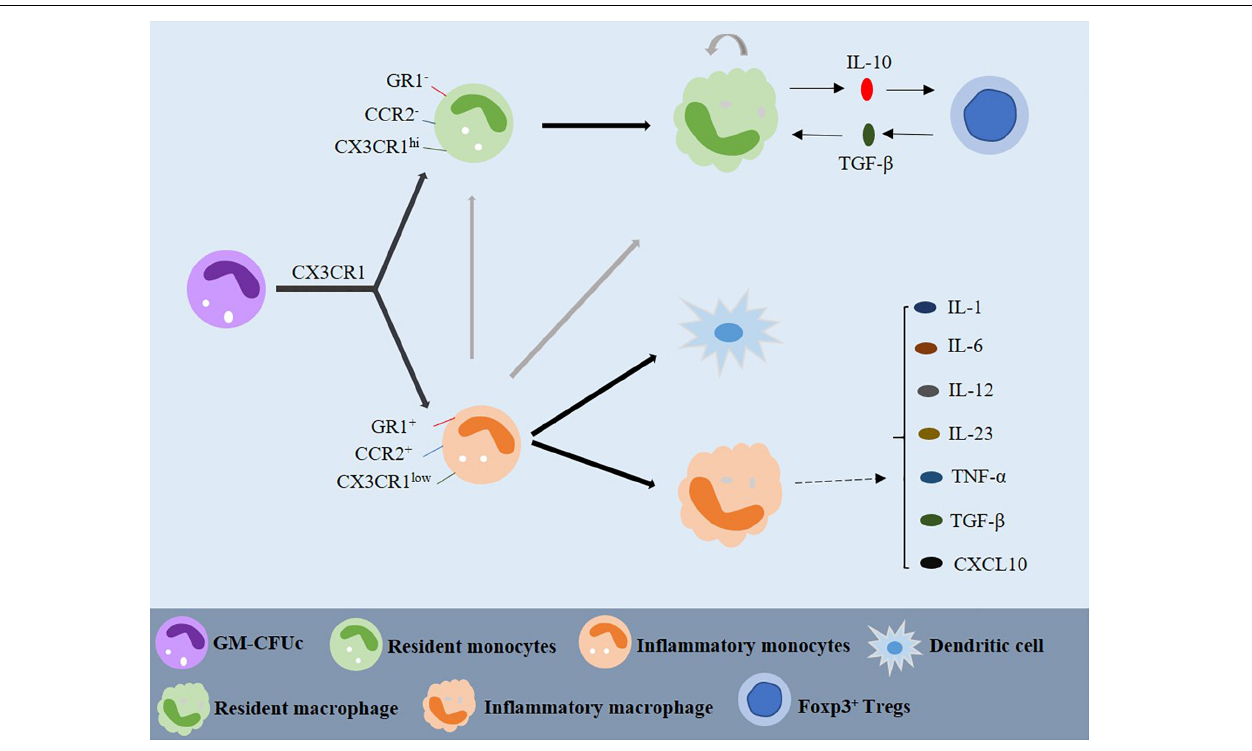
FIGURE 2 | Origin and differentiation of macrophages. GM-CFUc can be divided into resident and inflammatory monocytes by CX3CR1. Inflammatory monocytes may also be one of the sources of resident monocytes. Resident macrophages are usually produced by resident monocytes or, sometimes, by inflammatory monocytes. Resident macrophages and Foxp3 + T cells play a significant role in maintaining intestinal homeostasis through IL-10 and TGF- β dependent mechanisms. When there is inflammation in the intestine, inflammatory monocytes migrate to the intestine and differentiate into dendritic cells and inflammatory macrophages, which can produce a variety of cytokines involved in the inflammatory reaction. GM-CFUc: granulocyte macrophage colony forming unit; IL: interleukin; TNF- α : tumor necrosis factor- α ; TGF- β : transforming growth factor- β .